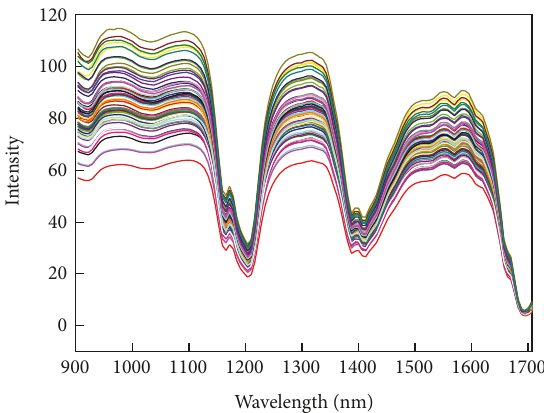
Figure 4: Transmittance spectra of perilla seed oil samples according to storage time.